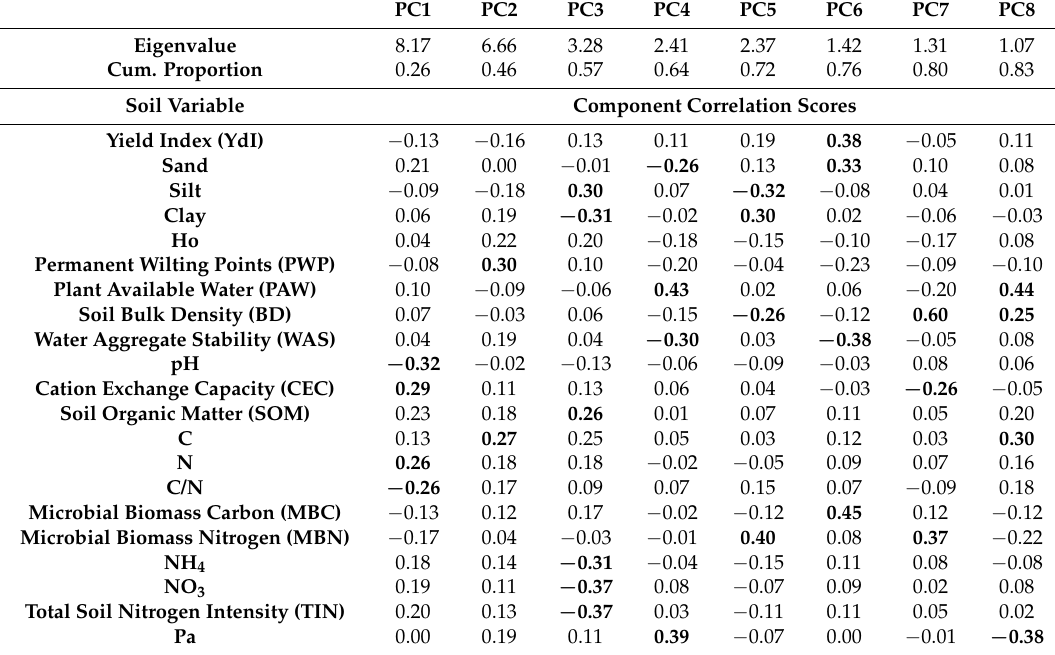
Table 1. Principal component analysis based on 32 observations modeling greenhouse gas (GHG) emissions (N 2 O, CO 2 , and CH 4 ) with 32 variables, with eigenvalues and the cumulative proportion of the dataset variability explained by eight principal components (PC) extracted from eigenvalues